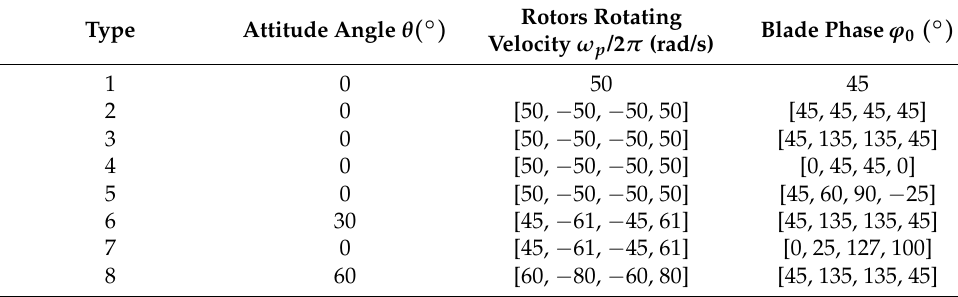
Table 1. Drone simulation parameters in different states.